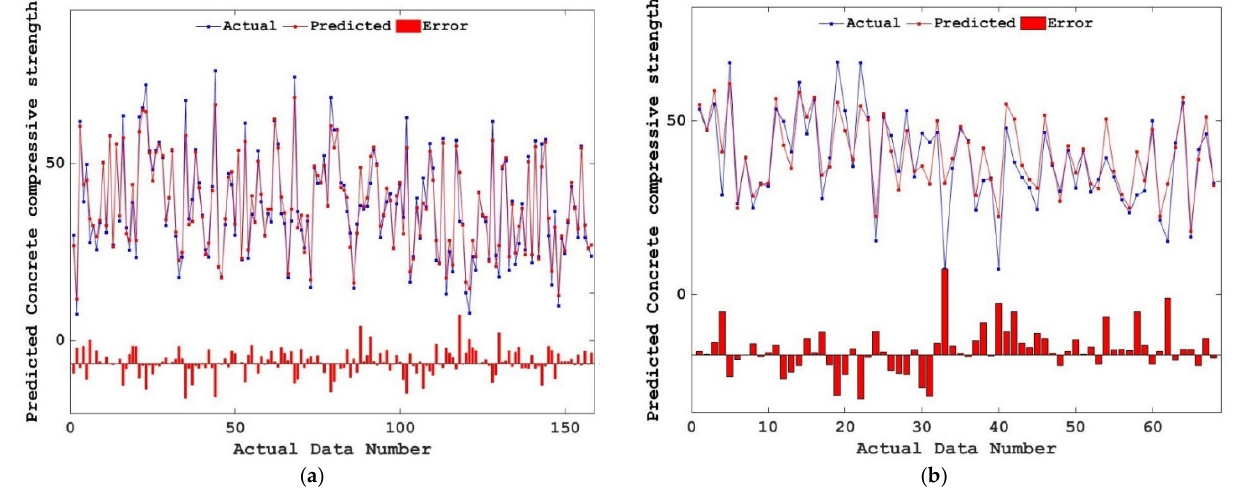
Figure 7. Comparison of the actual compressive strength and predicted compressive strength. ( a ) Training set; ( b ) Testing